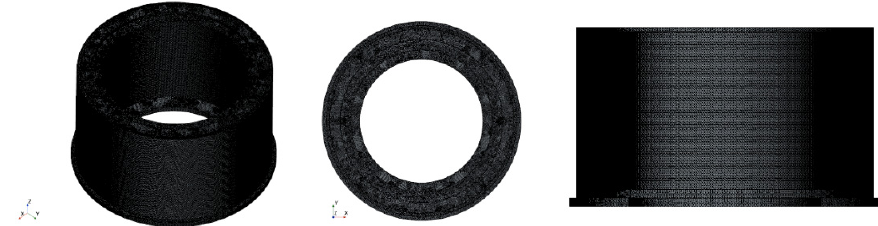
Figure 9. Different views of polyhedral mesh.